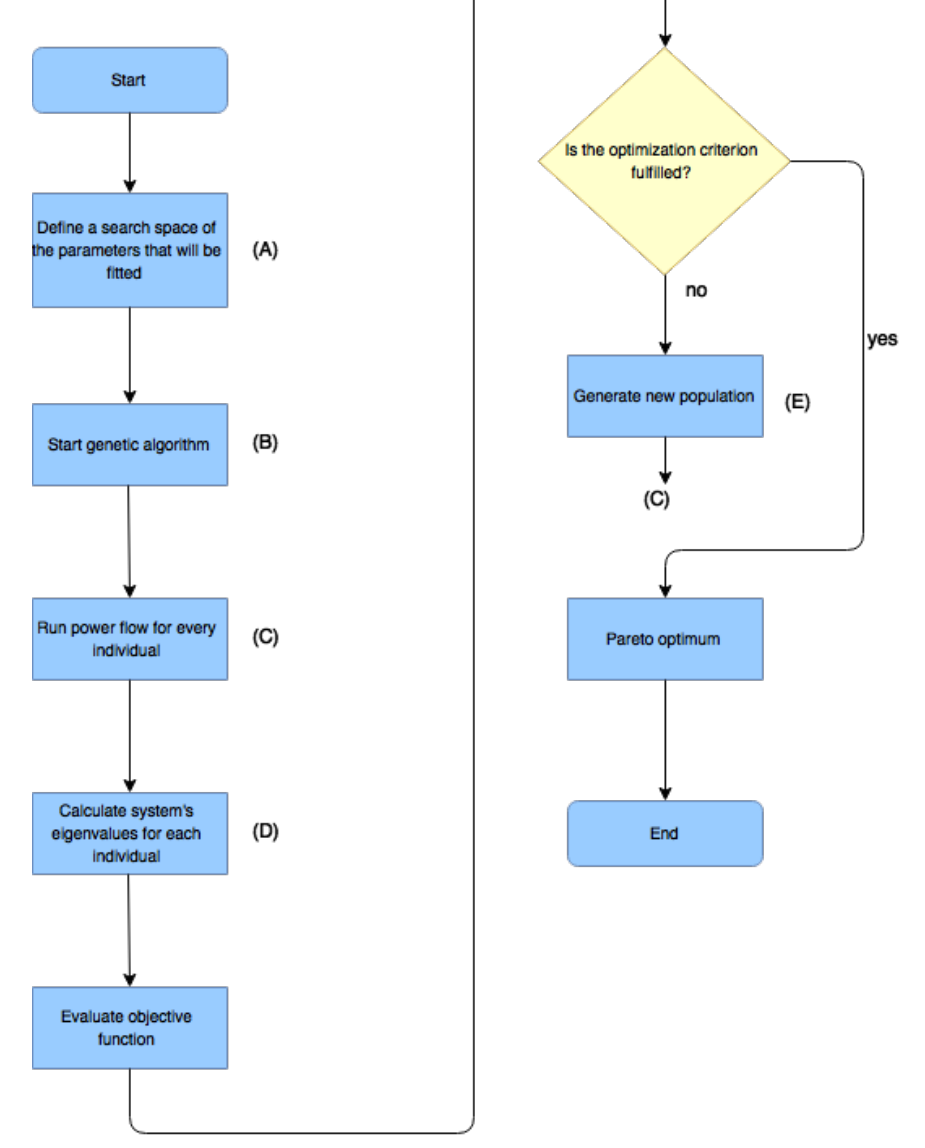
Figure 1. Search algorithm of the PSS parameters. NSGA II